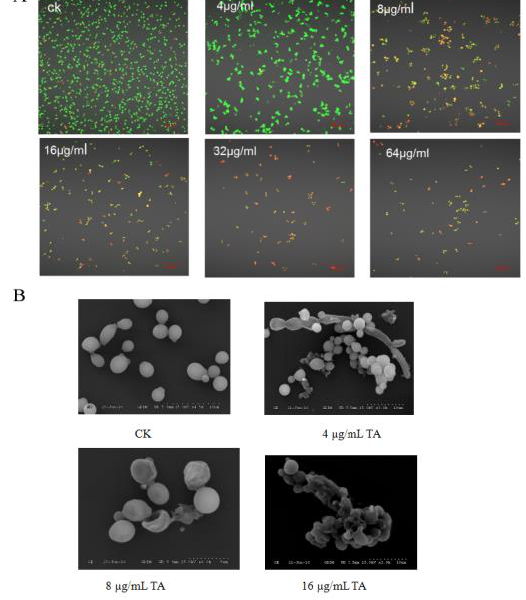
Figure 2. The observation of TA-treated C. albicans via laser confocal microscopy and scanning electronic microscopy: ( A ) Laser confocal observation. The magnification fold was × 400 fold with the scale of 50 µ m; ( B ) SEM observation. The scale was 10 μm.